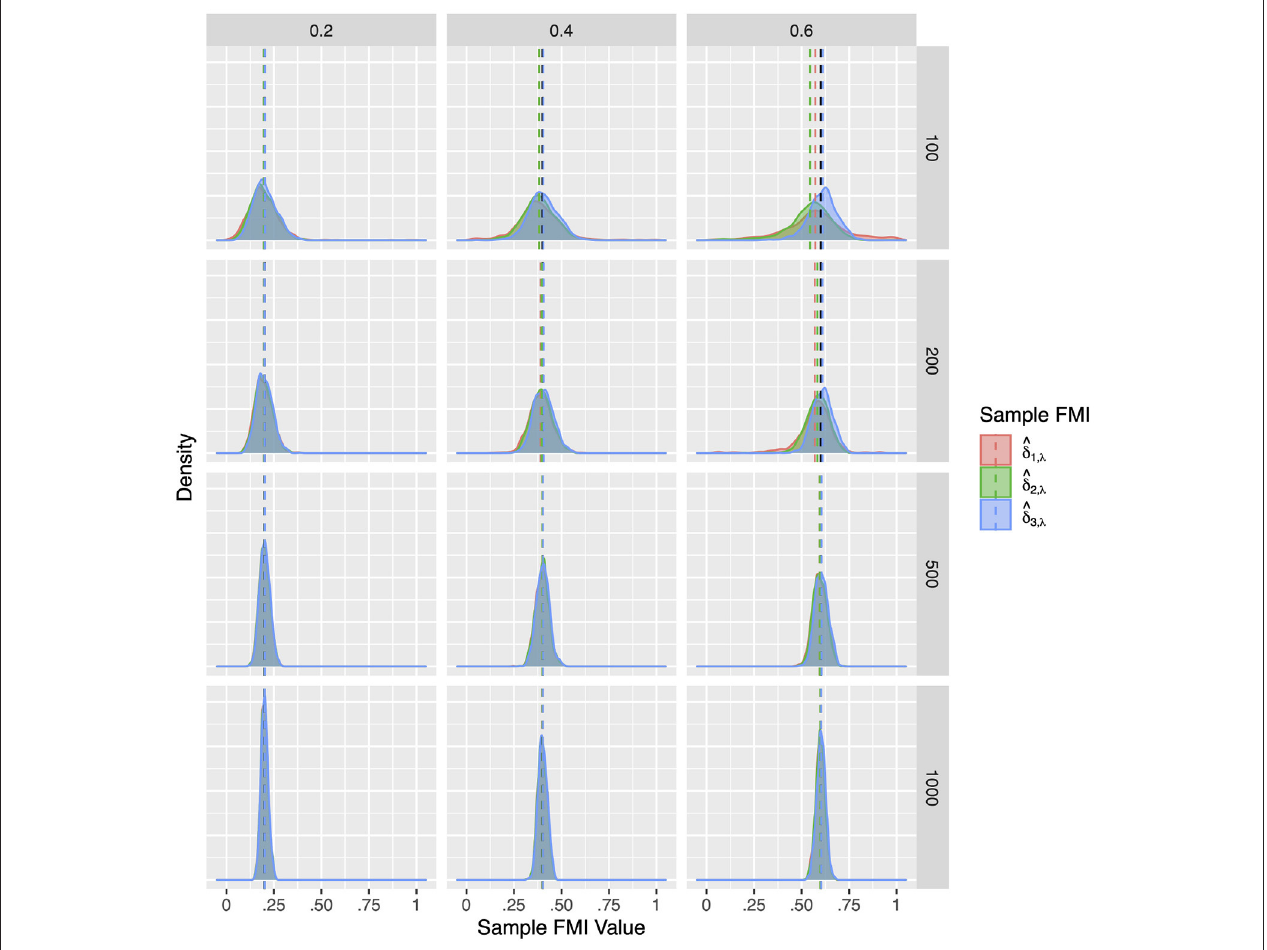
50,100,200, and 500. The panel =